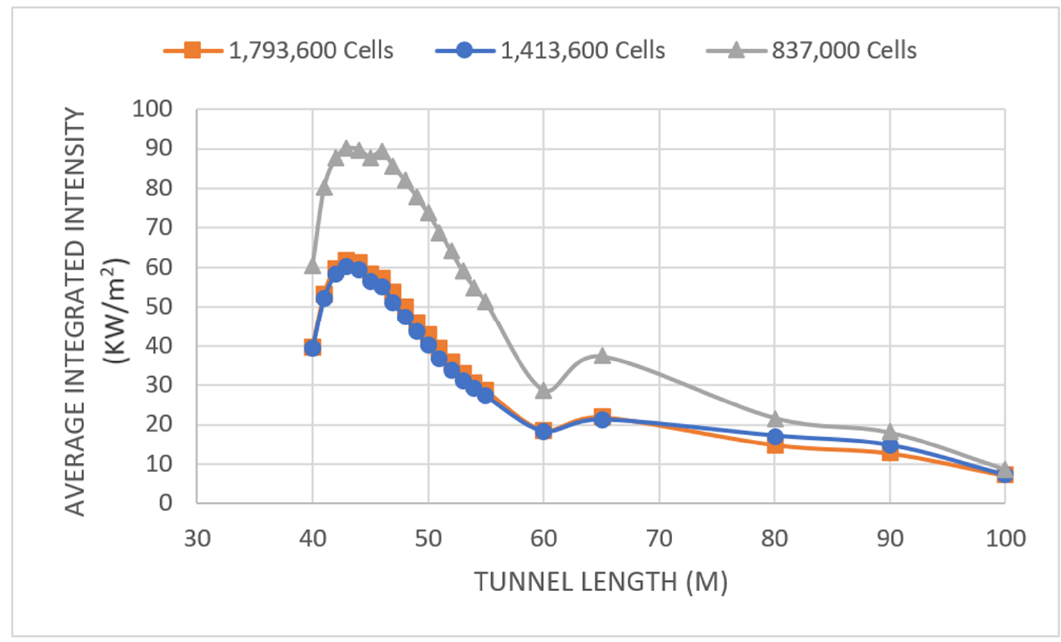
Figure 3. Radiative flux (integrated intensity) along the tunnel.